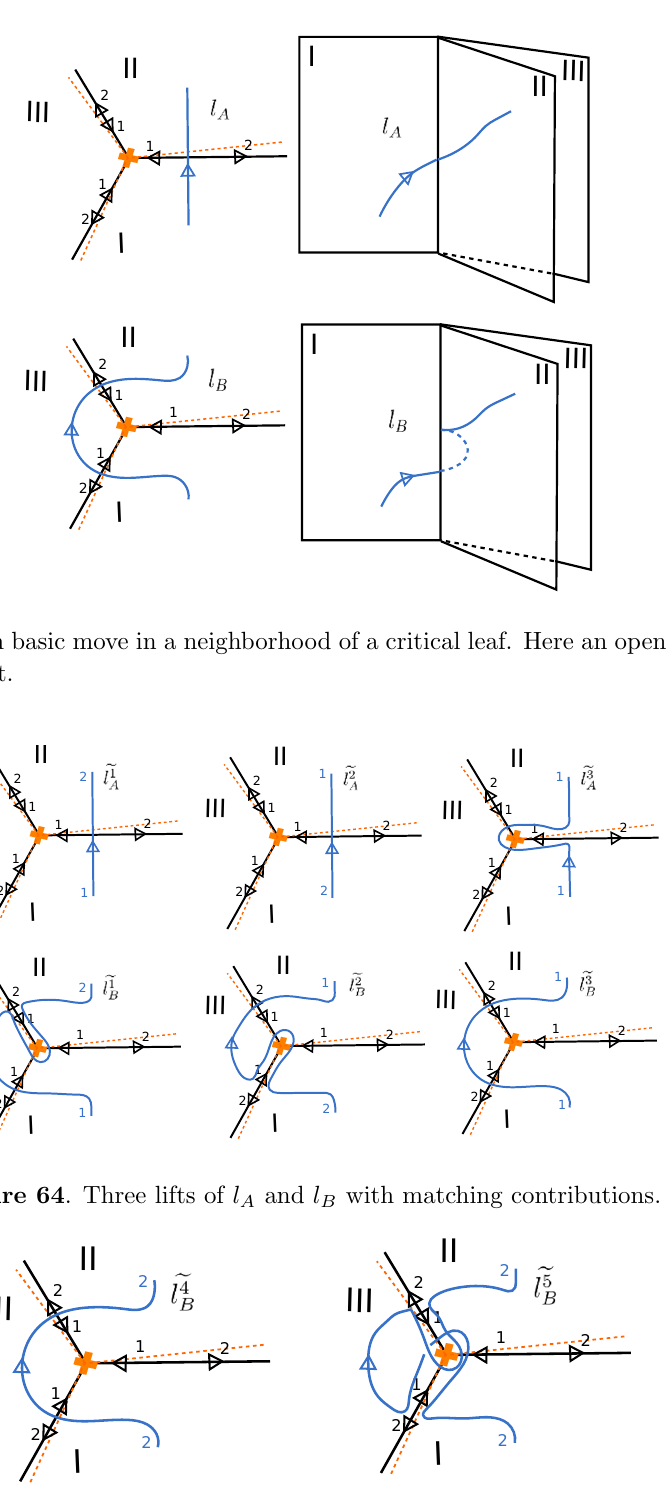
Figure 65 . Two lifts of l B whose contributions cancel with each